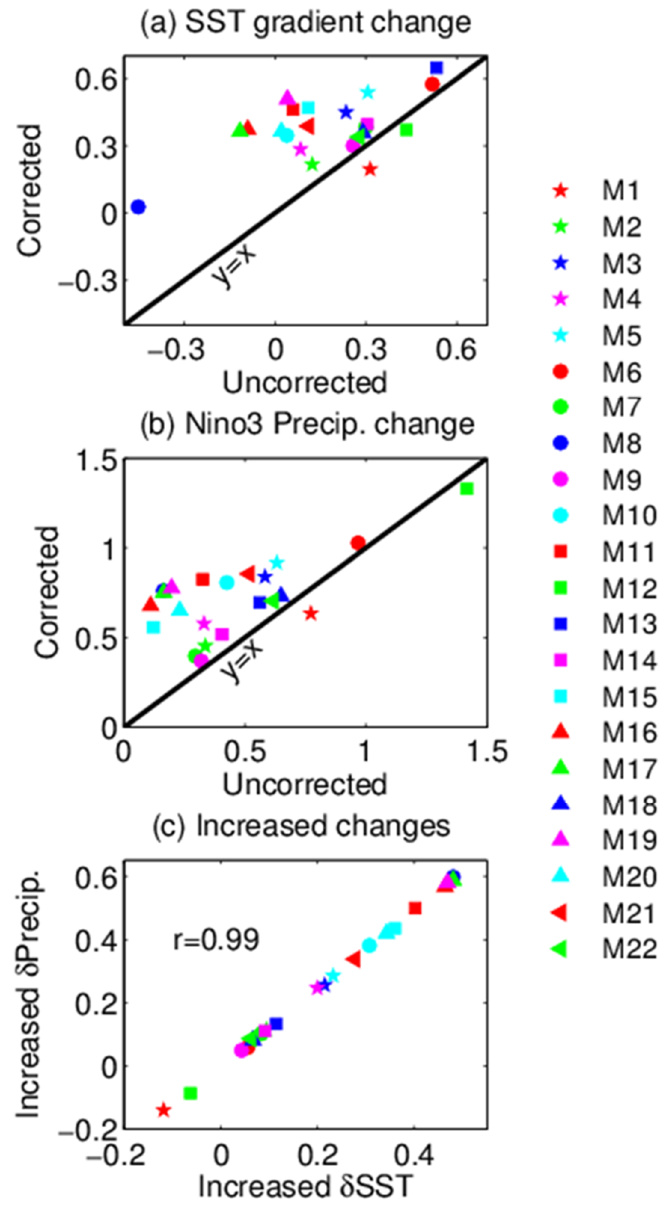
Figure 9. The uncorrected and corrected changes in the ( a ) east–west SST (°C) gradient in the equatorial Pacific and ( b ) Niño3 DJF precipitation (mm/day) under the RCP 8.5 scenario. ( c ) Relationship between corrected-minus-uncorrected changes in the east-minus-west gradient of equatorial Pacific SST and Niño3 DJF precipitation among the 22 models.